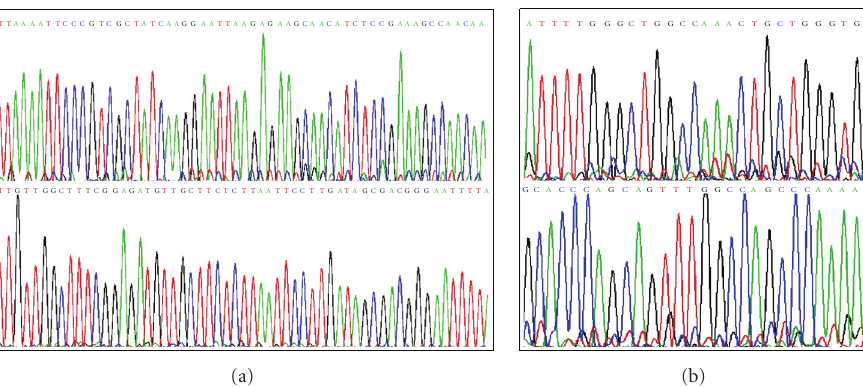
Figure 2: Chromatograms of PCR products. (a) graphs displaying exon 19 sense and antisense strands on top and bottom, respectively. (b) Graphs displaying exon 21 sense and antisense strands on top and bottom respectively. In both exons 19 and 21 no significant double peaks were obtained signifying the absence of any mutations within these reading